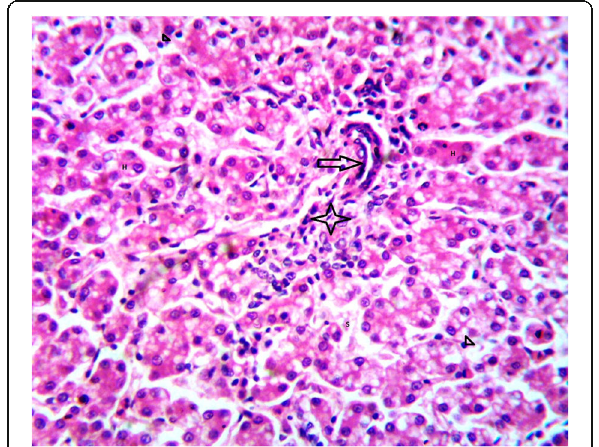
Fig. 4 Liver section of broiler chicken fed 0.0% of PCHM-inclusive diet showing the hepatic tissue composed of sheets of hepatocytes (H) separated by the sinusoids (S). The central vein (arrow) appears